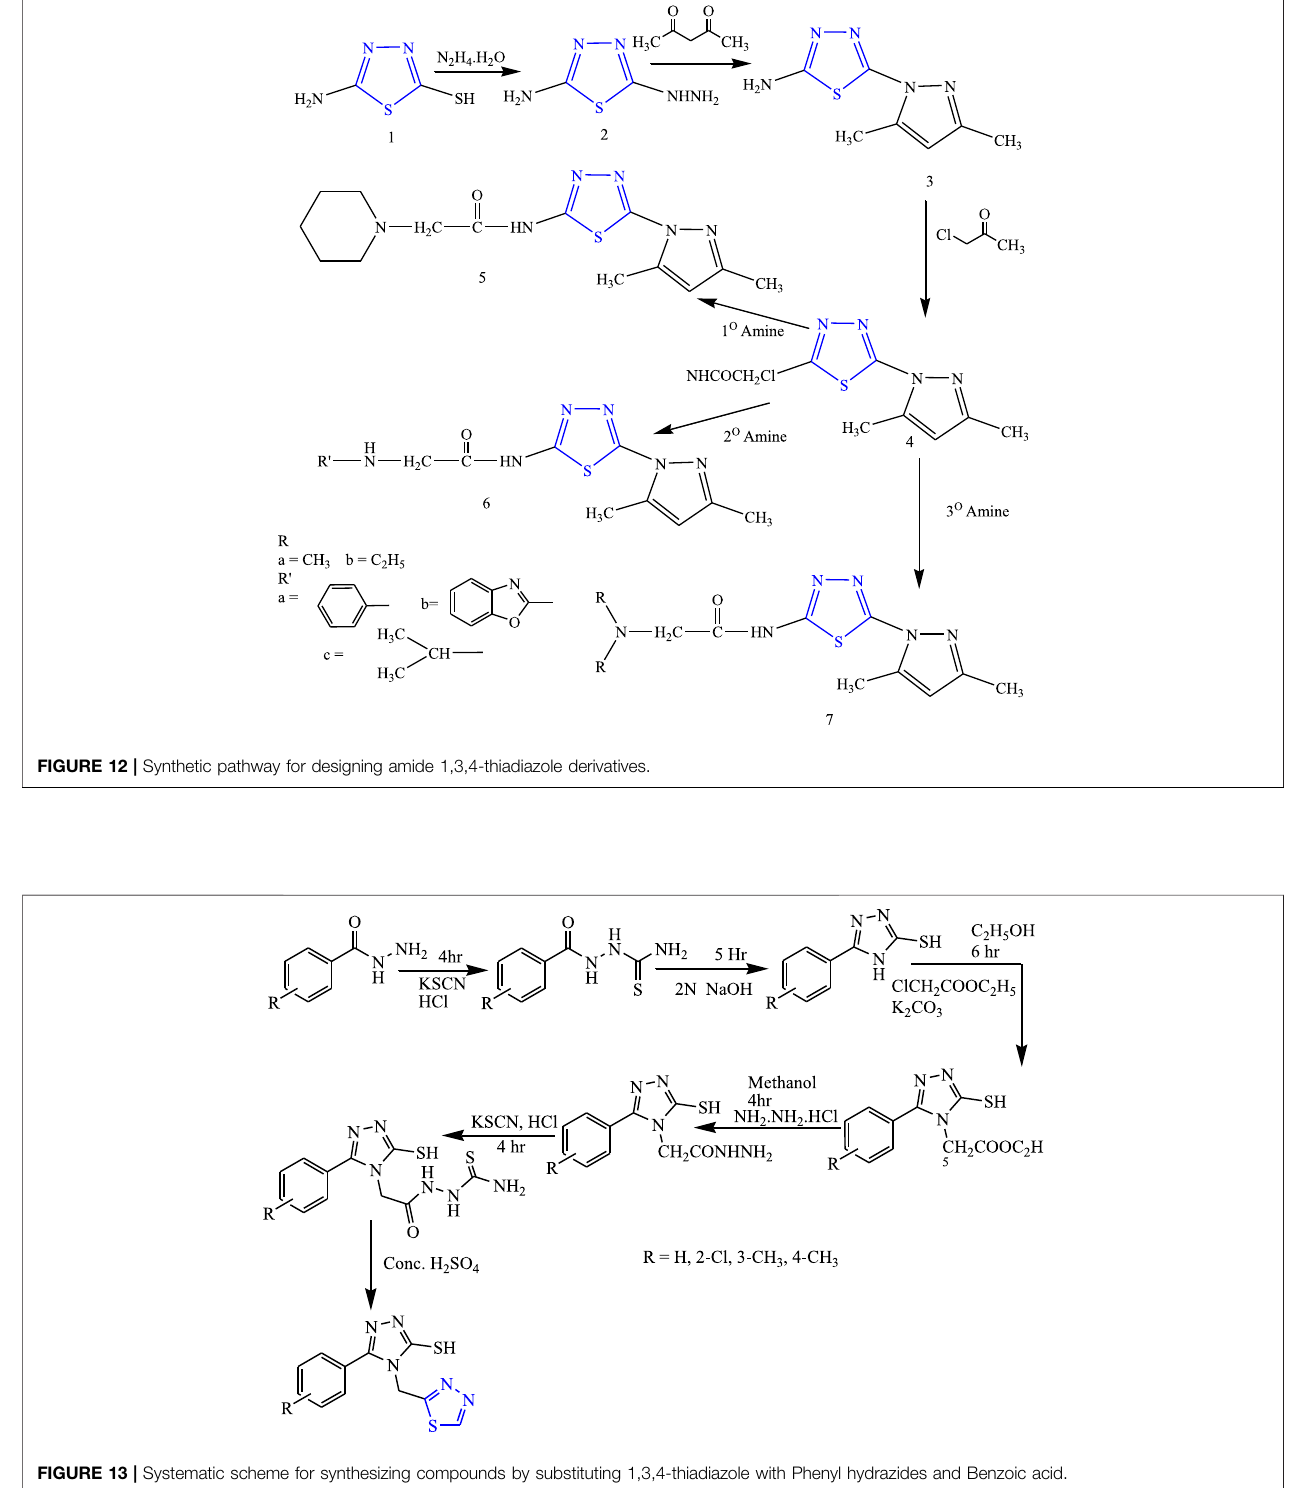
Frontiers in Chemistry |